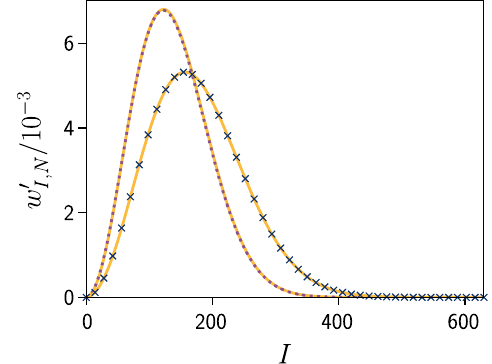
intervals.FIG. 12. Weighting factors for each I manifold. The purple dotted curve is the exact expression for the weights w 0 I;N for N ¼ 30 000 , with the corresponding approximate version in yellow. We show only the latter for the case of N ¼ 49 000 , overlaid with the 46 sampled points used in our simulations (blue